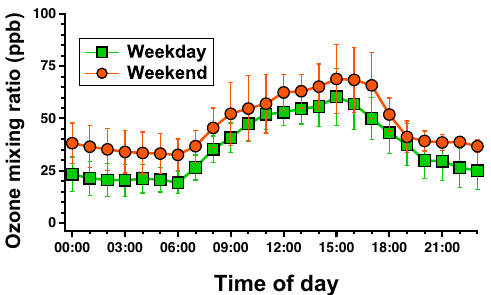
Figure 7. Mean diurnal cycles of the ozone mixing ratio (ppb) measured in Redlands, California. Weekdays and weekends are defined as in Fig. 6. Peak values occur at 15:00 and correspond to 60 . 4 ± 13 . 6ppb ( ± 95% confidence interval) on weekdays and 68 . 9 ± 16 . 5ppb on weekends.